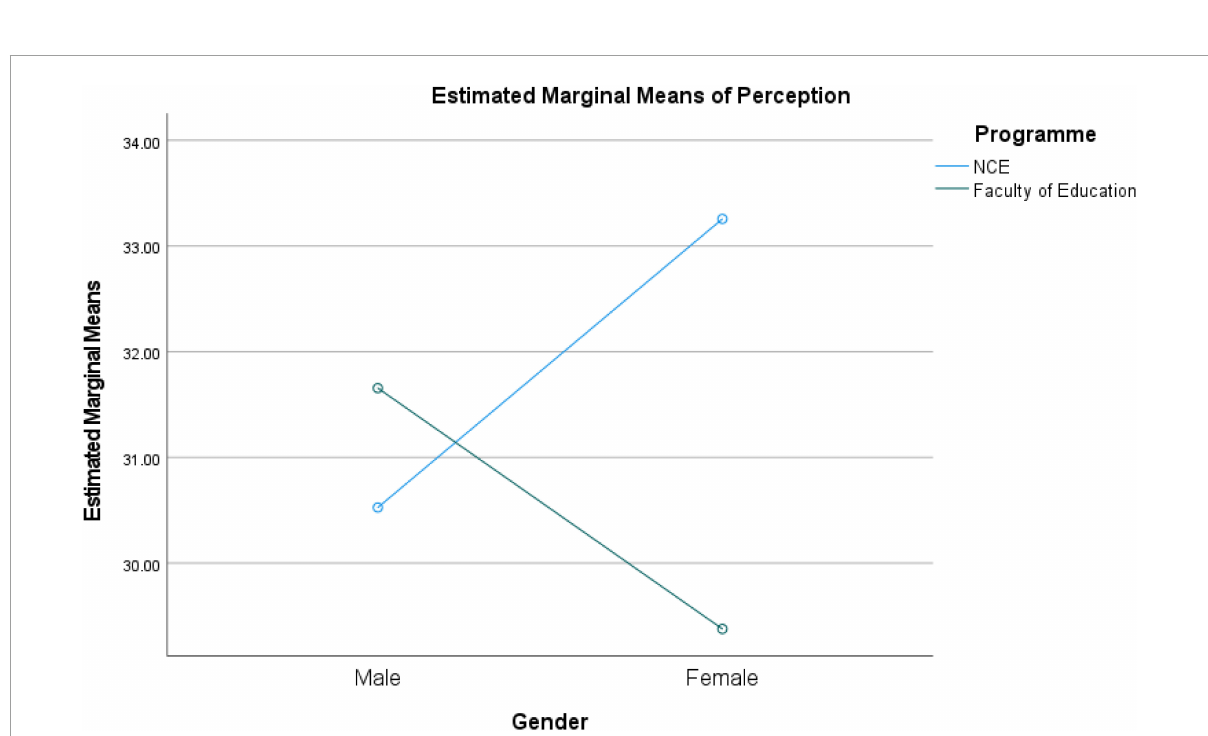
FIGURE2 Estimated marginal means interaction between gender and programs on pre-service teacher perception about inclusive